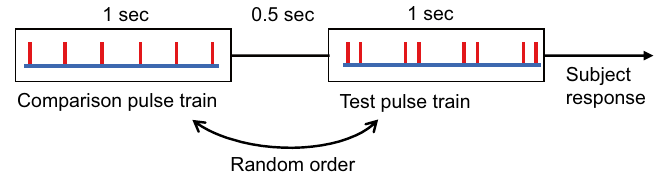
Figure 1. Two-interval force-choice